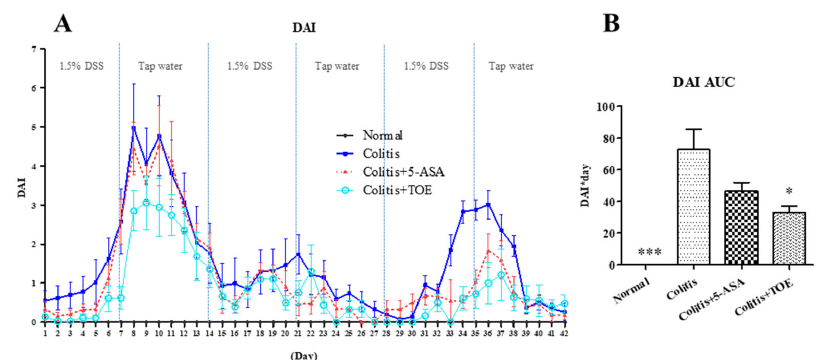
Figure 5. Effect of M2 fraction of Turbinaria ornata extract (TOE) on clinical severity of DSS ‐ induced chronic colitis in C57BL/6 mice. ( A ) Disease activity index (DAI) score ( B ) DAI area under the curve (AUC) graph. * p < 0.05, *** p < 0.001, compared with the colitis group. Normal, DSS ‐ /D.W; Colitis, DSS + /D.W, Colitis + 5 ‐ ASA, DSS + /5 ‐ ASA 50 mg per kg; Colitis + TOE, DSS + /TOE 15 mg per kg.